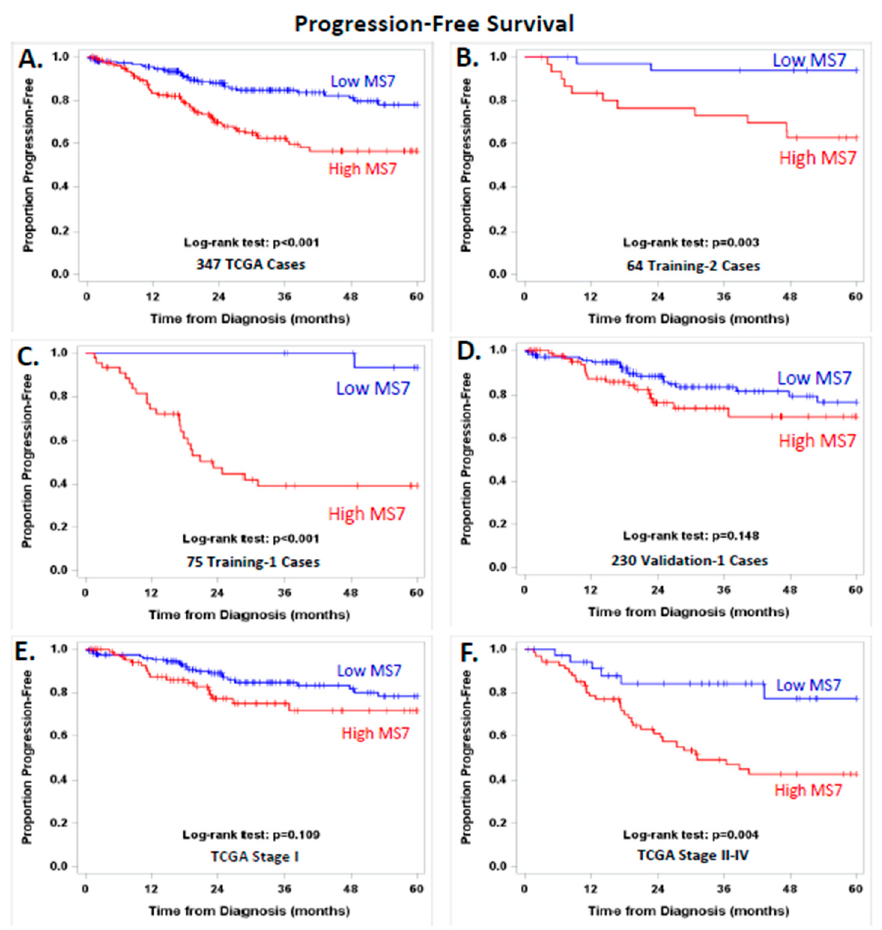
Figure 3. Progression-free survival plots were generated using the Kaplan–Meier method, and survival distributions were compared using log-rank tests for women with low (blue line) vs. high (red line) MS7 scores in 347 EEC patients with stage I–IV disease from the Cancer Genome Atlas Research Network (TCGA) ( A ); 64 EEC patients in the Training-2 cohort with stage I, IIIC, or IV disease ( B ); 75 EEC patients in the Training-1 cohort with stage I, IIIC, or IV disease ( C ); 230 EEC cases from the Validation-1 cohort with stage I, IIIC or IV disease ( D ); EEC patients from TCGA with stage I disease ( E ); and EEC patients from TCGA with stage II-IV disease ( F ). MS7 scores were categorized using the platform-centric cut points ( − 2.00356 for the RNAseq-based algorithm and − 4.25324 for the microarray-based algorithm).